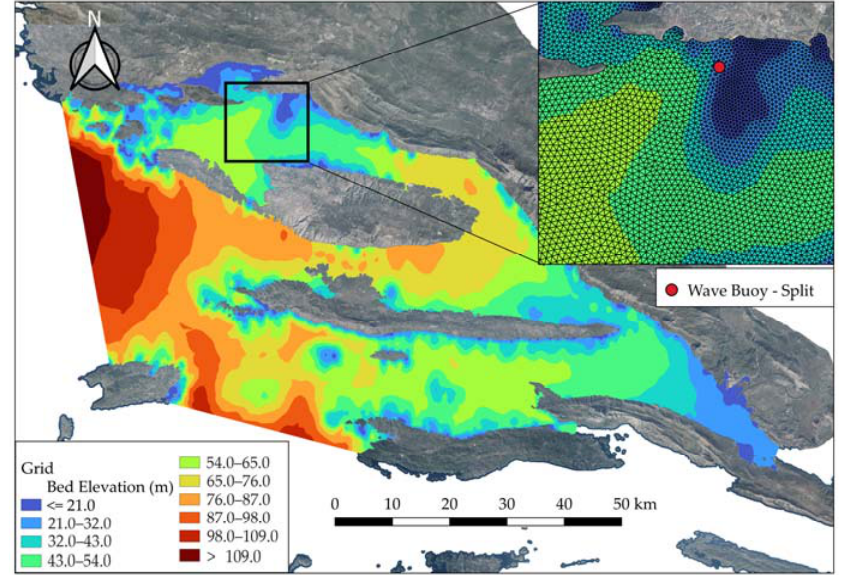
Figure 4. Map of the regional model on the southern Croatian coast (mid-latitude Adriatic), showing the grid sizes of the ERA5 and ALADIN wind reanalysis models overlaid for size comparison, and four wind stations (rectangles) and one wave station (circle) described in detail in Section 2.3; MEDSEA reanalysis data from the Copernicus database is imposed on the open boundary; the map is shown in the coordinate reference system EPSG: 4326—WGS 84.